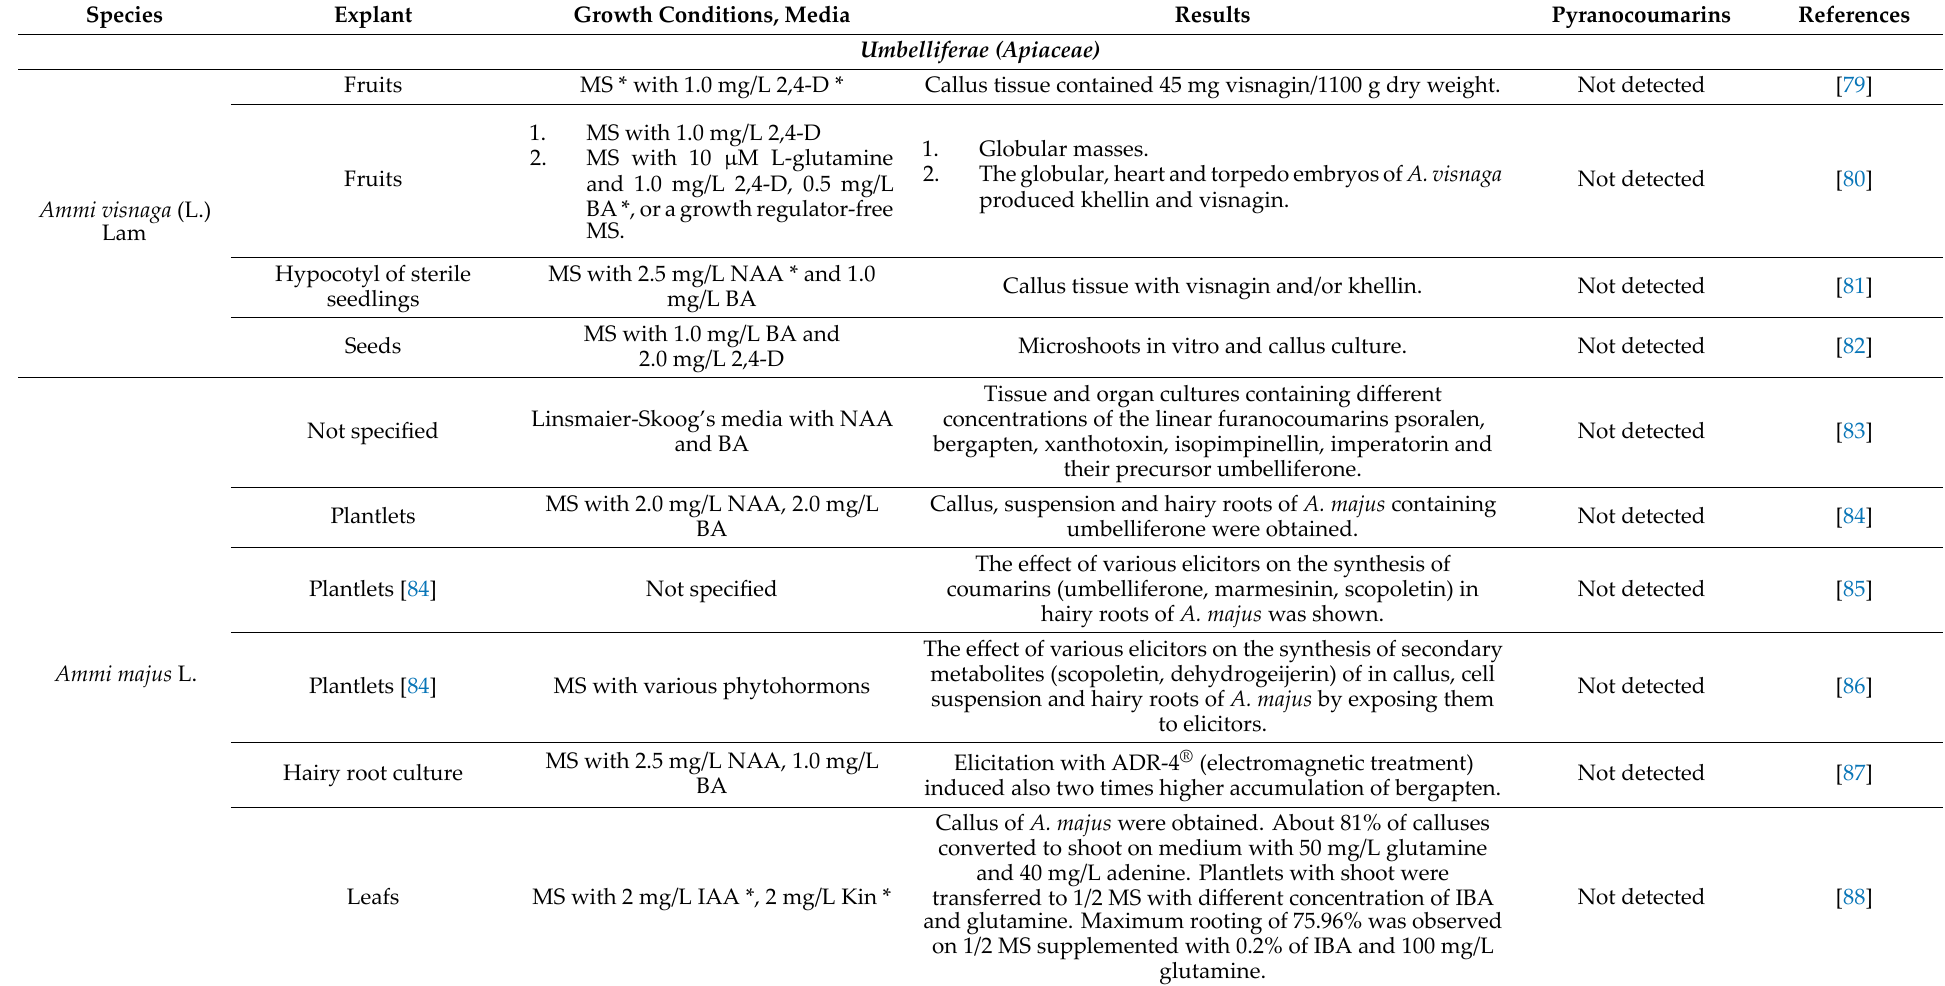
Table 2. Cell cultures of pyranocoumarin